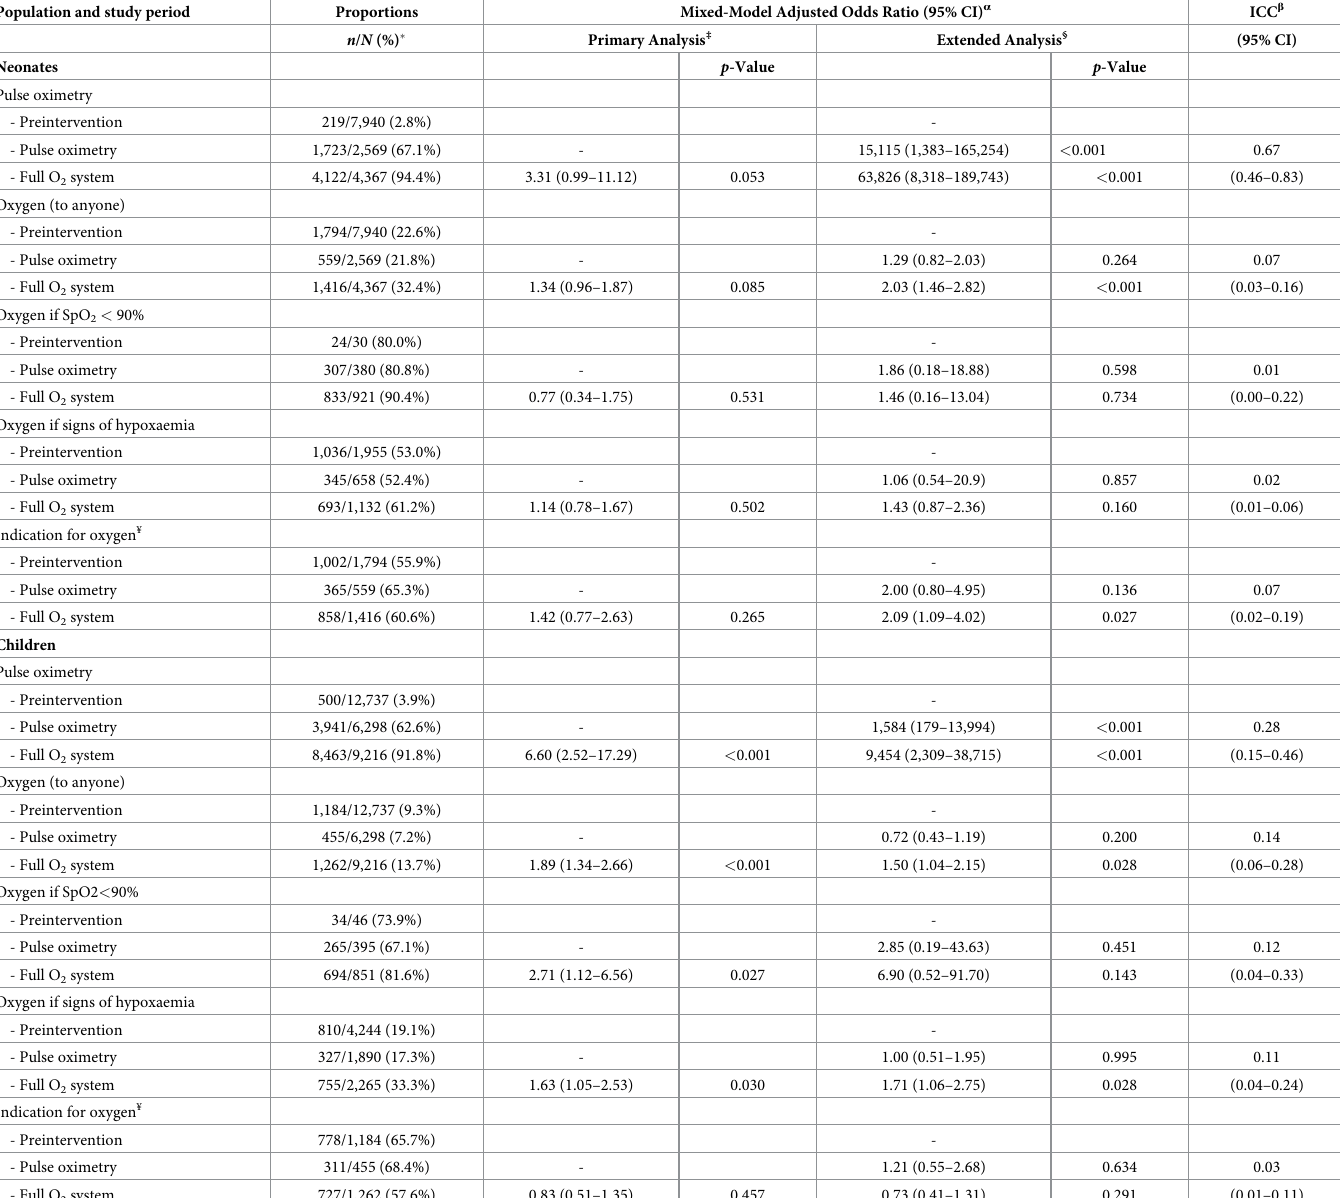
Table 4. Effect of the intervention(s) on practice outcomes, showing the primary analysis (full oxygen period versus pulse oximetry period) and extended analysis (comparing pulse oximetry and full oxygen system periods to the preintervention